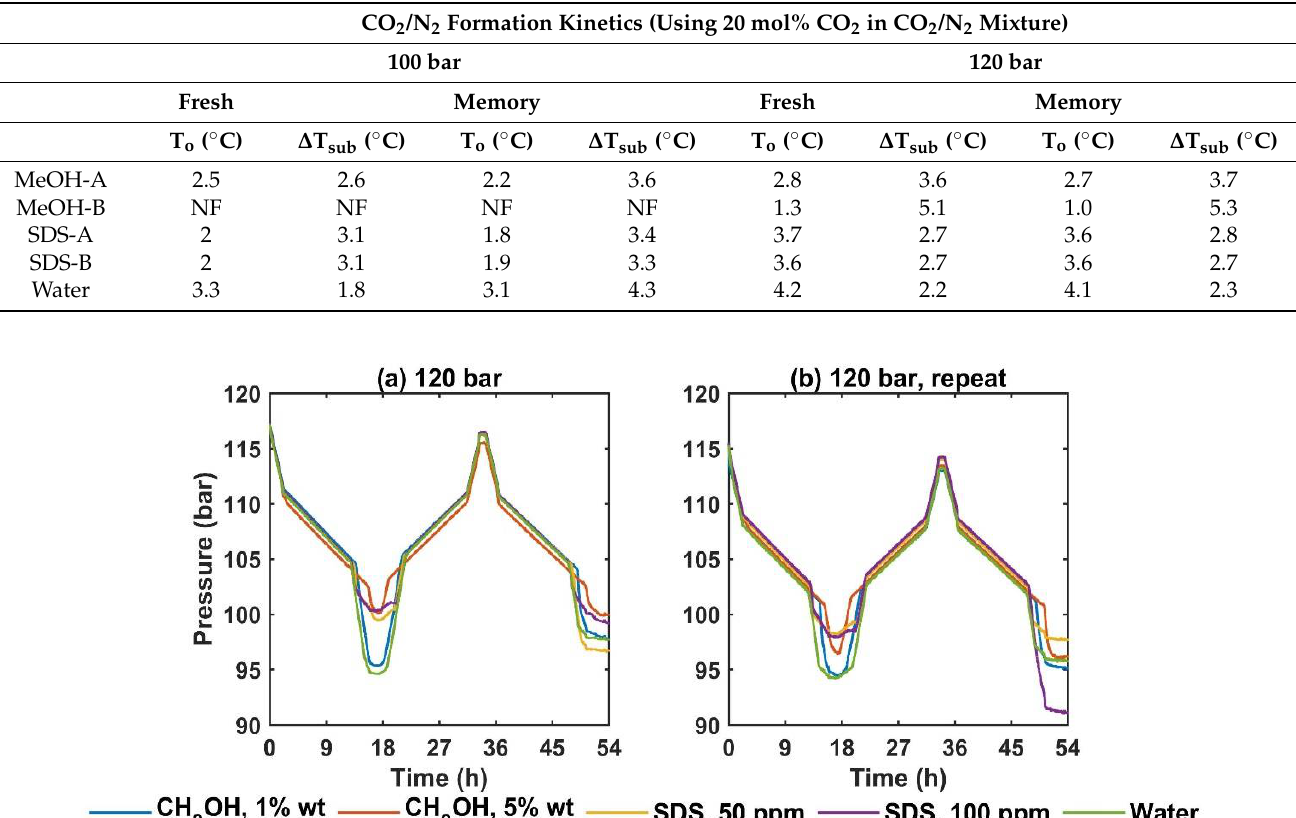
Table 5. Onset nucleation temperature To ( ◦ C) (averaged) and sub ( ∆ T sub ) for CO 2 /N 2 hydrate in the presence of MeOH and SDS (T eq = 6.32 ◦ C for 120 bar and T eq = 5.11 ◦ C for 100 bar); NF = No formation.